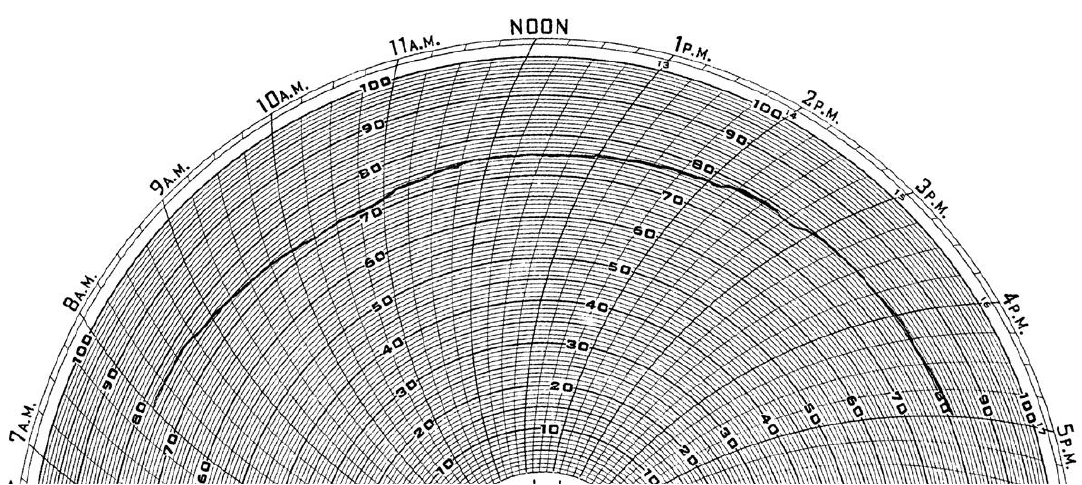
Figure 10. Values of pressures p [MPa] with a display coefficient of 0.08 in the pipeline in a time range of approximately 9 h were obtained from the pipeline operator control station.